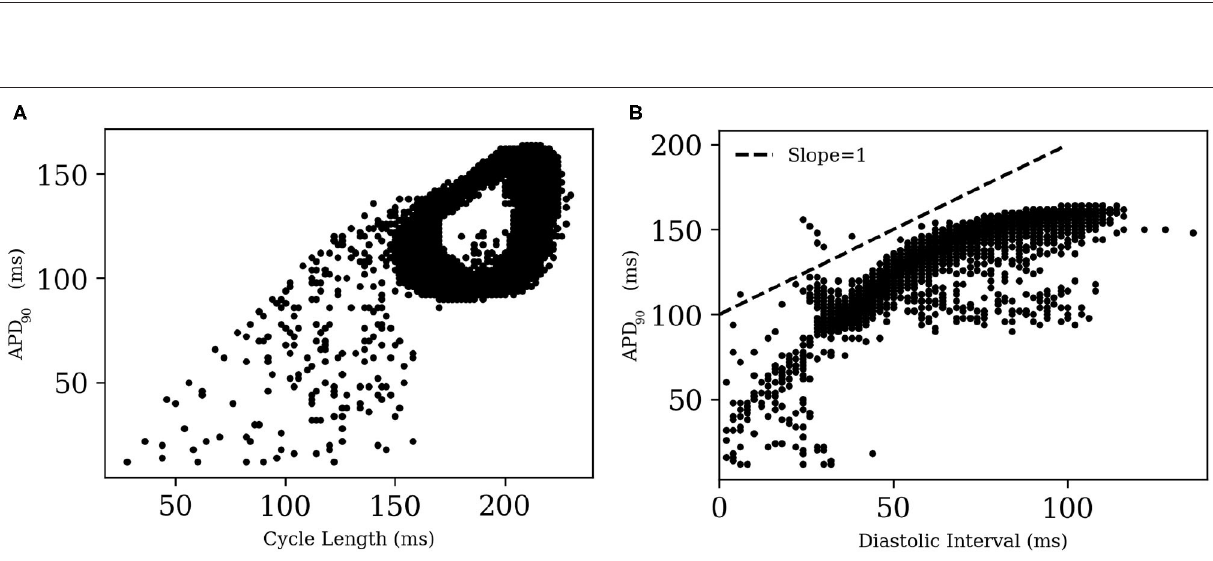
Frontiers in Physiology |